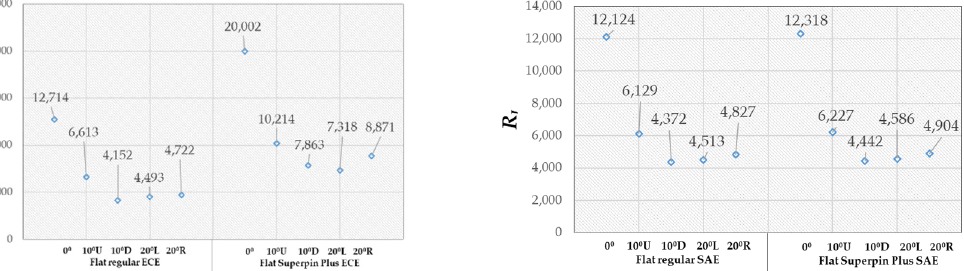
Figure 8. Comparison of the coe ffi cient of luminous intensity R I between the flat regular CCR and the flat SuperPin Plus